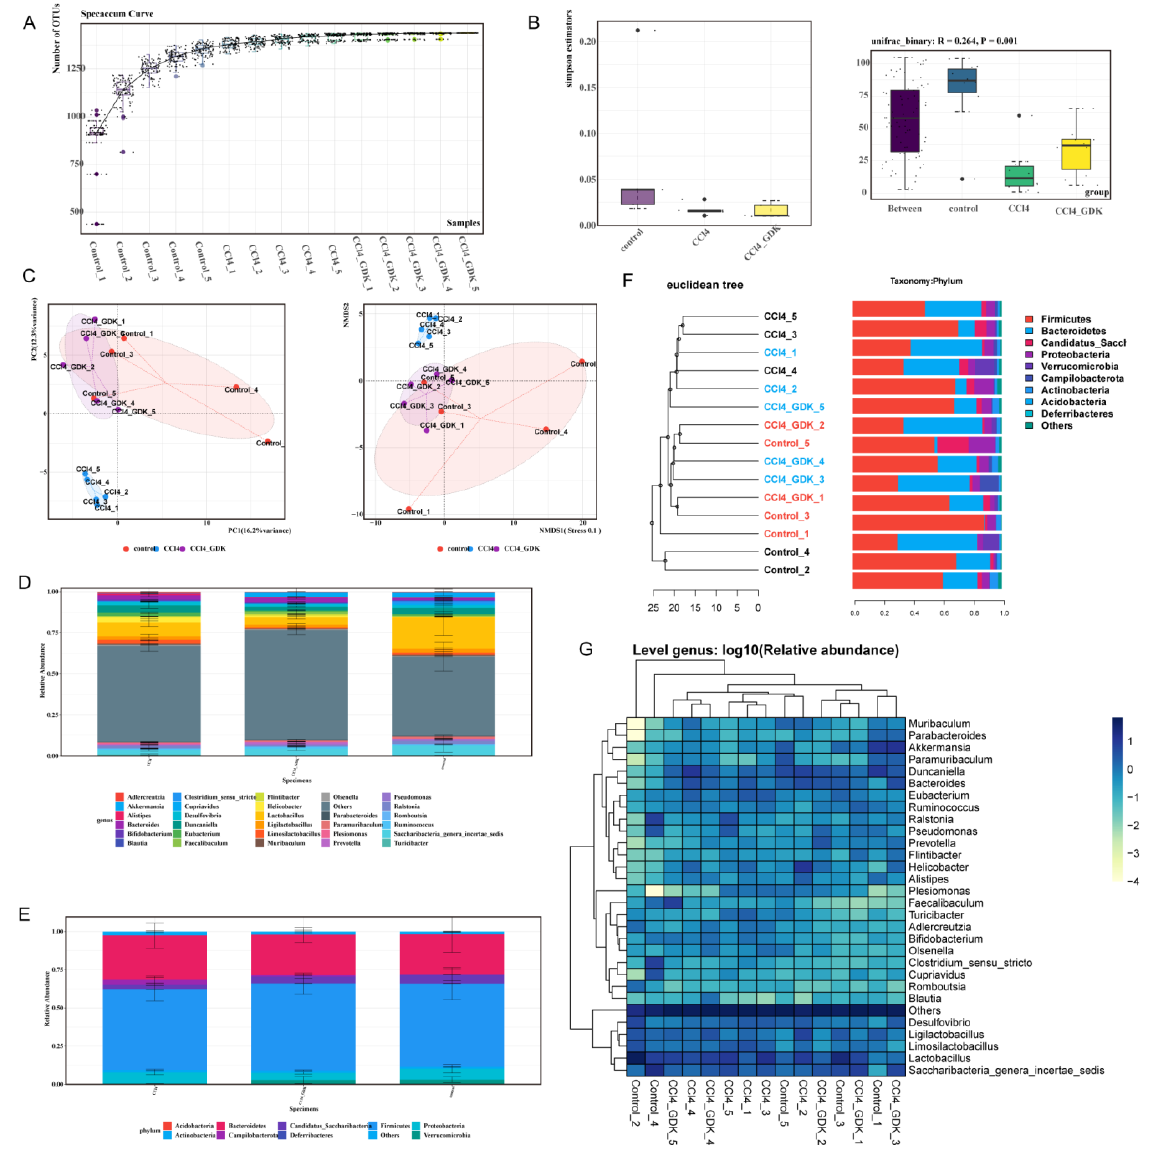
Figure 6. GDK restores intestinal flora diversity to curb chronic liver injury. ( A ) Species accumulation curves ( B ) α -diversity upon oral administration of GDK. ( C ) β -diversity of PCoA and NMDS plots upon GDK administration, as assessed by Euclidean distance at genus levels. ( D , E ) The relative abundance of bacterial phyla ( D ) and genera ( E ). ( F ) UPGMA clustering tree based on Euclidean distance and information statistics of Top 10 species at the phylum level. ( G ) Abundance cluster diagram at genus levels (n = 5 per group). R software (version 3.2.3) was used for statistics and visual display of species annotation results. It uses (https://bitbucket.org/nsegata/hclust, accessed on 23 September 2021) to construct heat maps of some species information at the OTU level and different classification levels as well as to carry out cluster analysis among samples and species.